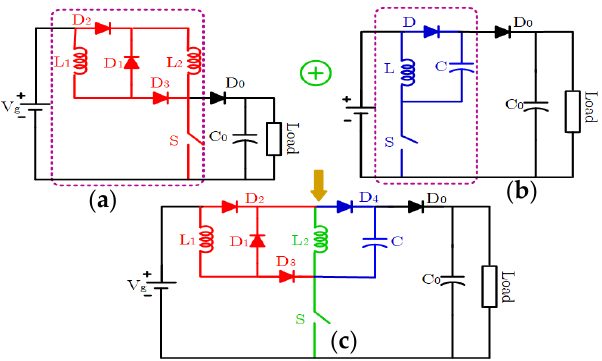
Figure 2. DC ‒ DC converter topologies ( a ) Super-lift boost converter ( b ) Elementary Luo converter ( c ) Hybrid switched inductor-based voltage-lift converter.